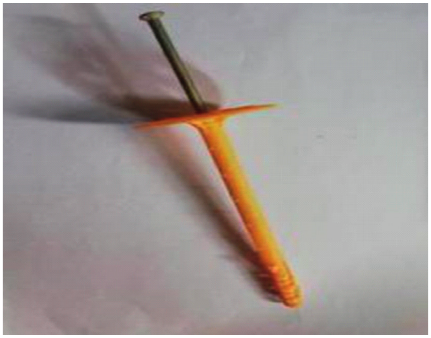
Figure 2: Plastic anchor